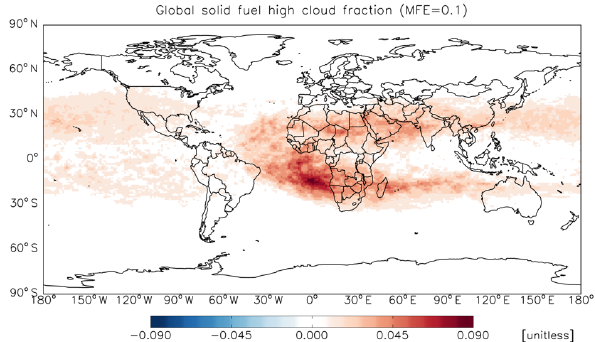
Figure 9. Global distribution of high cloud fraction due to solid fuel cookstove aerosol emissions with BC as IN and MFE =